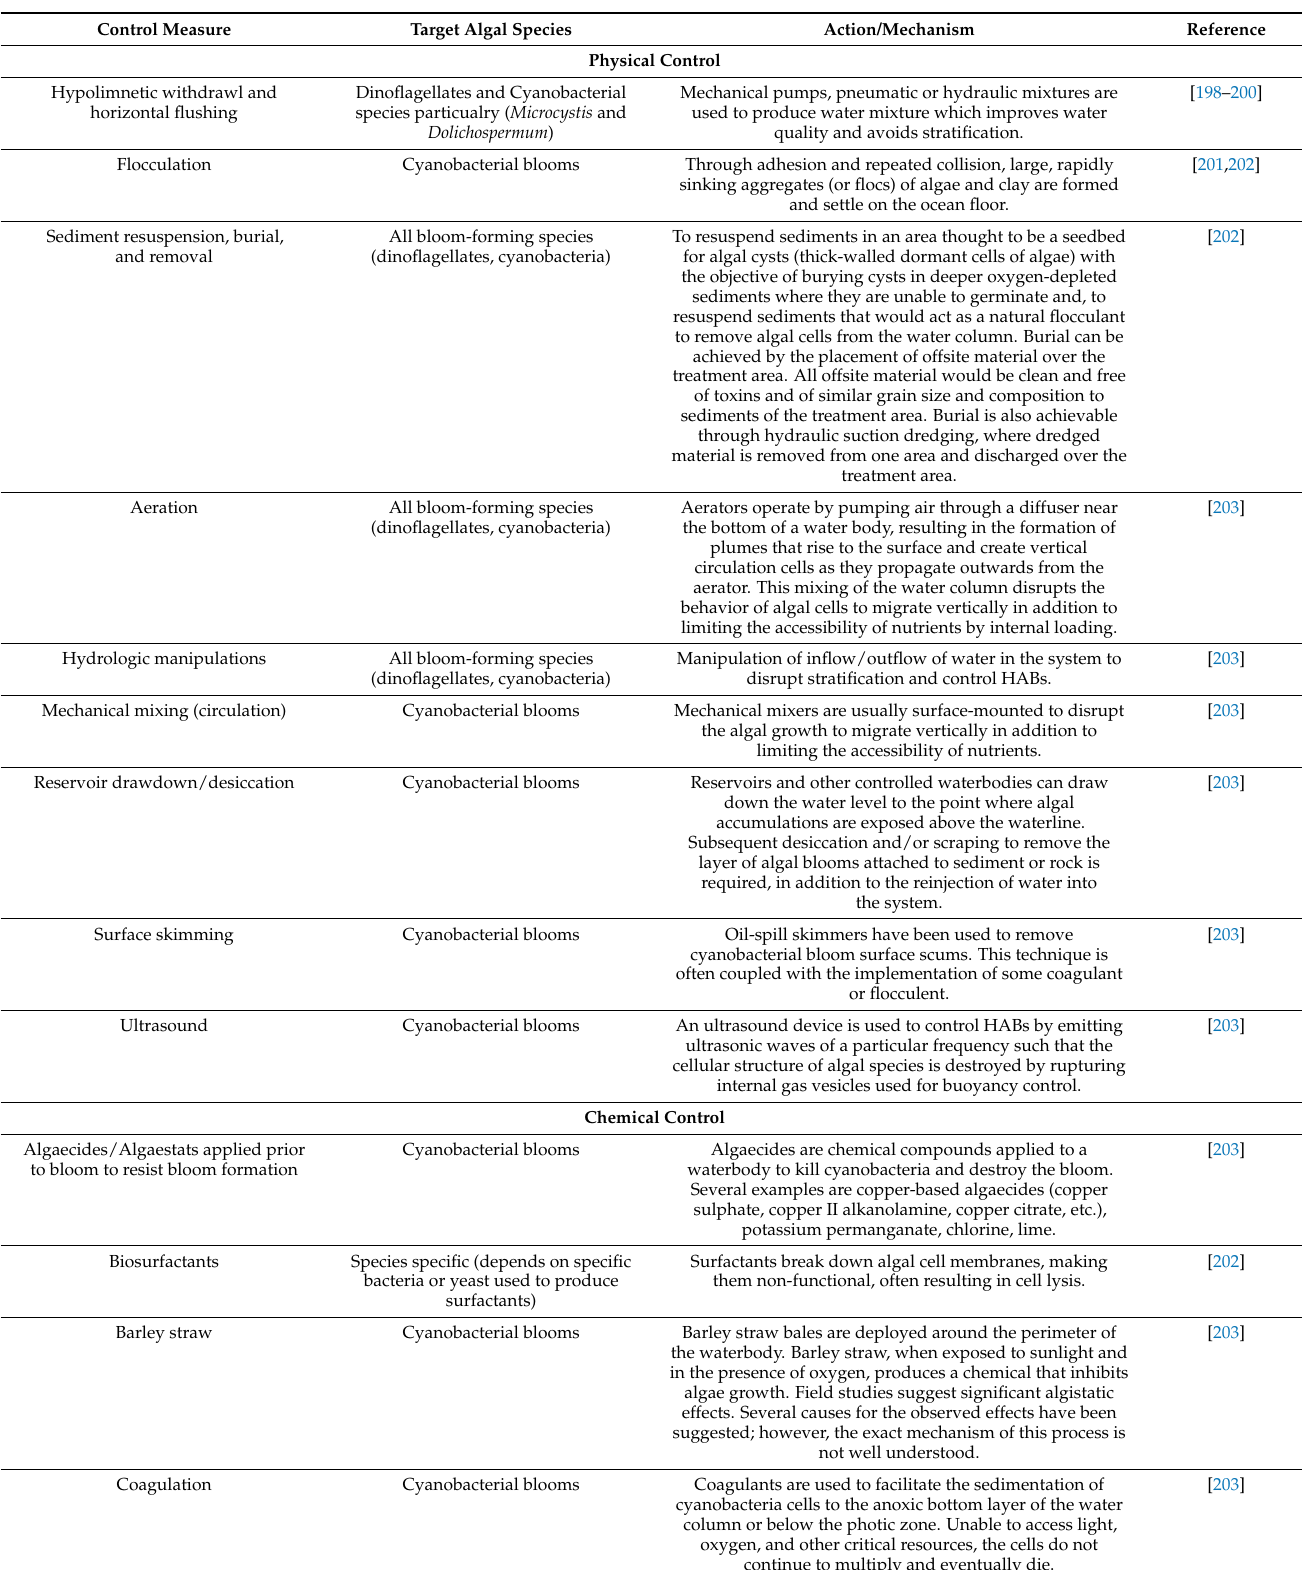
Table 3. Summary of methods for controlling